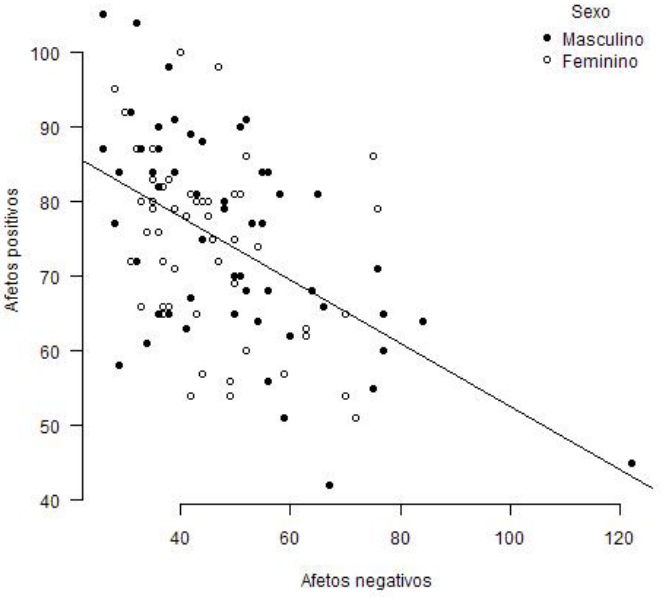
Figura 1 . Correlação entre afetos positivos e afetos negativos ( N =106).